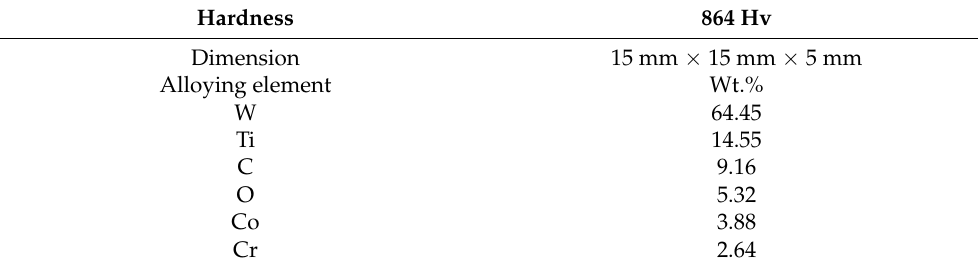
Table 2. The details of test workpiece.